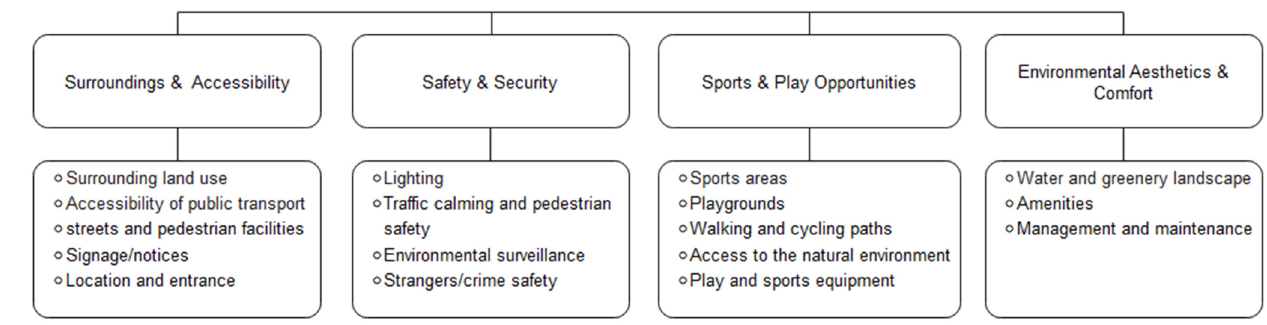
Figure 2. Audit tool dimensions and items.